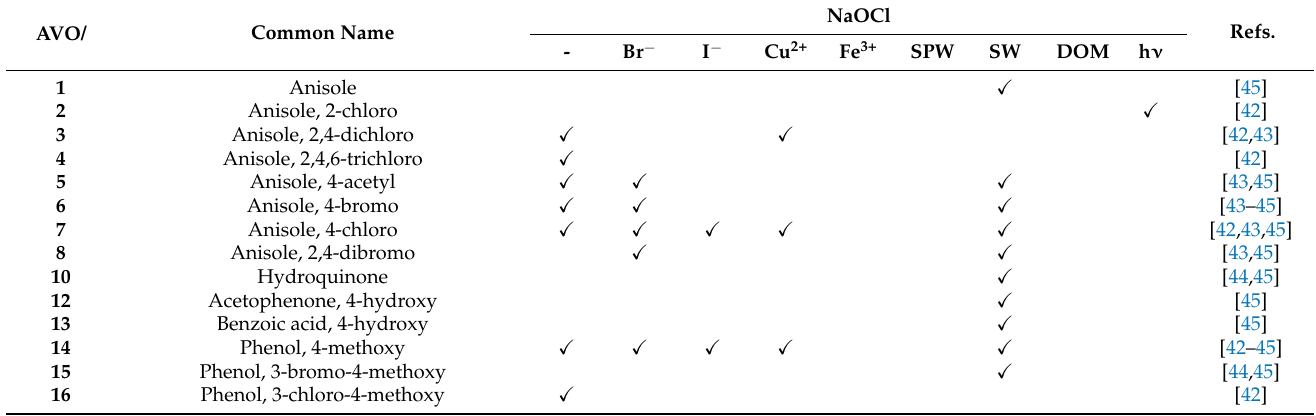
Table 3. Products obtained by hypochlorination in the presence of light and ions and in different aqueous